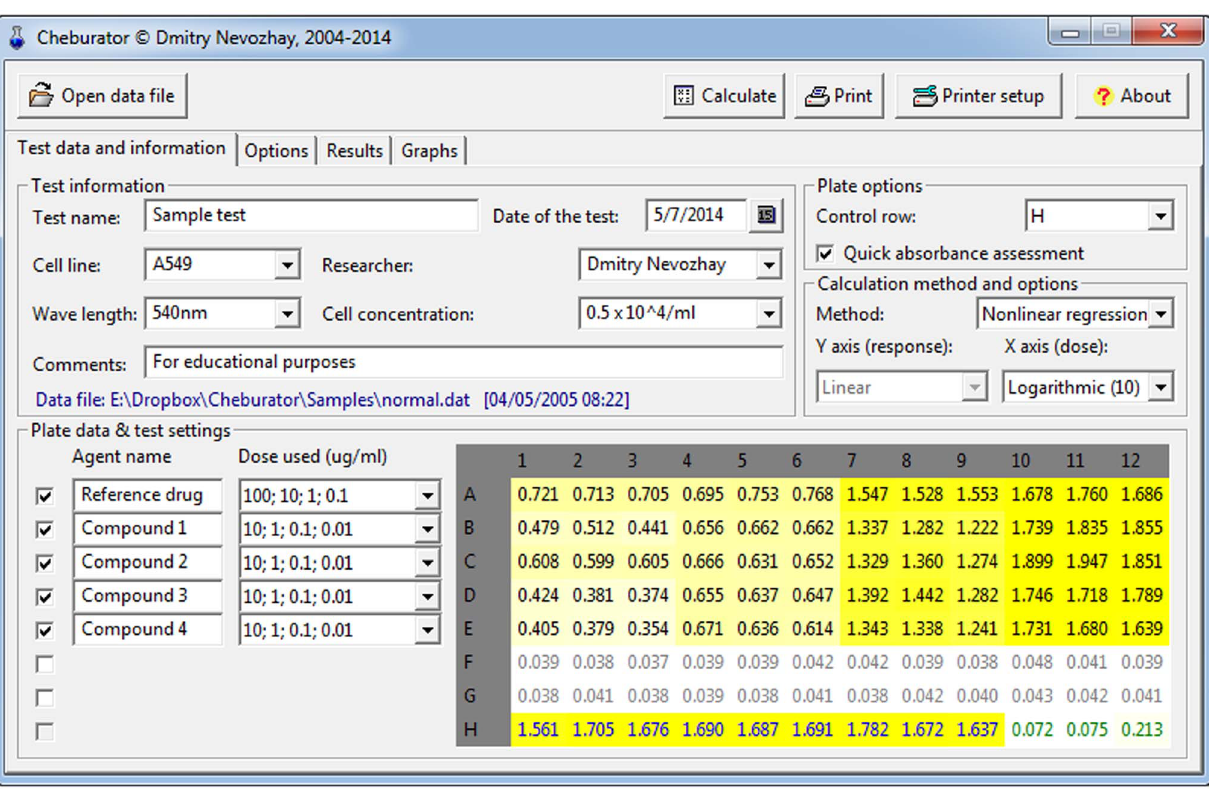
Figure 4. Main window of the program, showing the test parameters and plate data table. The absorbance values in wells are highlighted with the intensities proportional to the ratio between their respective values and control values.